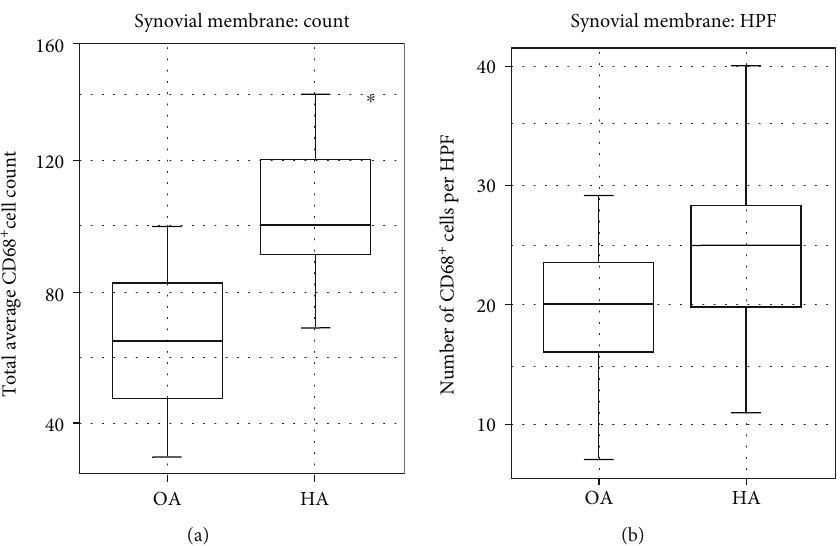
Figure 5: The average count of the CD68 + cells (a) and its number per HPF (b) in the synovial membrane. The data has been presented as a mean value ± standard deviation (SD). ∗ p < 0 : 05 . OA: osteoarthritis; HA: hemophilic arthropathy.